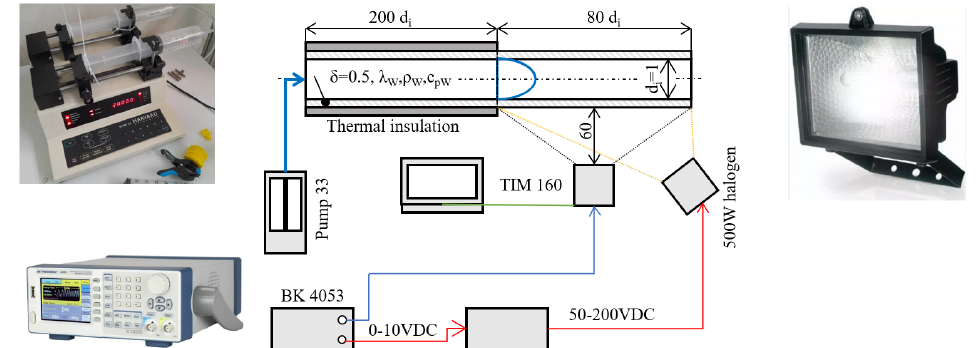
Figure 8. Drawing of the experimental equipment, its connection and details of the measured pipe. Dimensions are in mm. In a real application, the halogen reflector is just above the IR camera and aims at the center of the measurement zone.